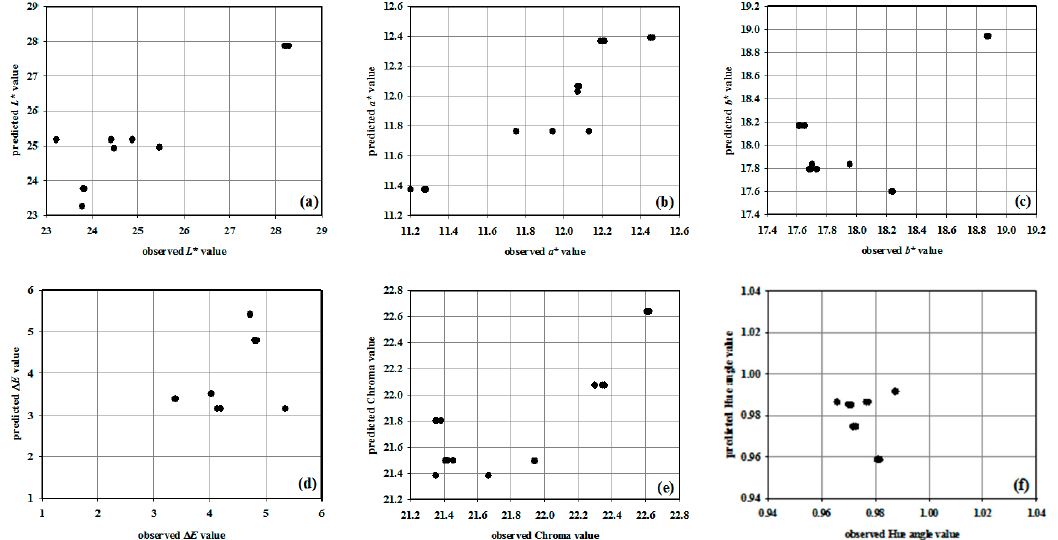
Figure 2. Non-linear regression models for description of color component change during storage of L1KMK estimated using Statistica 10.0.: ( a ) L* , ( b ) a* , ( c ) b* , ( d ) ∆ E , ( e ) Chroma, ( f ) Hue angle ( R 2 = 0.918, 0.936, 0.783, 0.819, 0.794, 0.843).